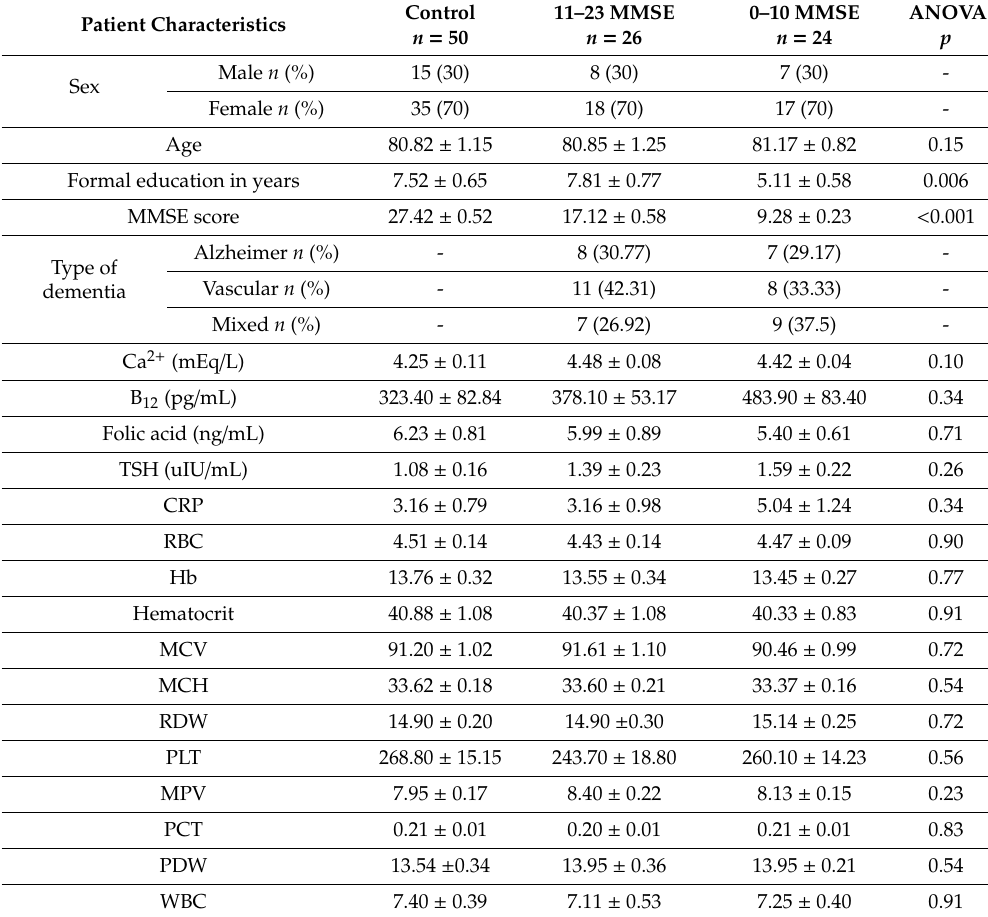
Table 2. Clinical characteristics of dementia patients and the control